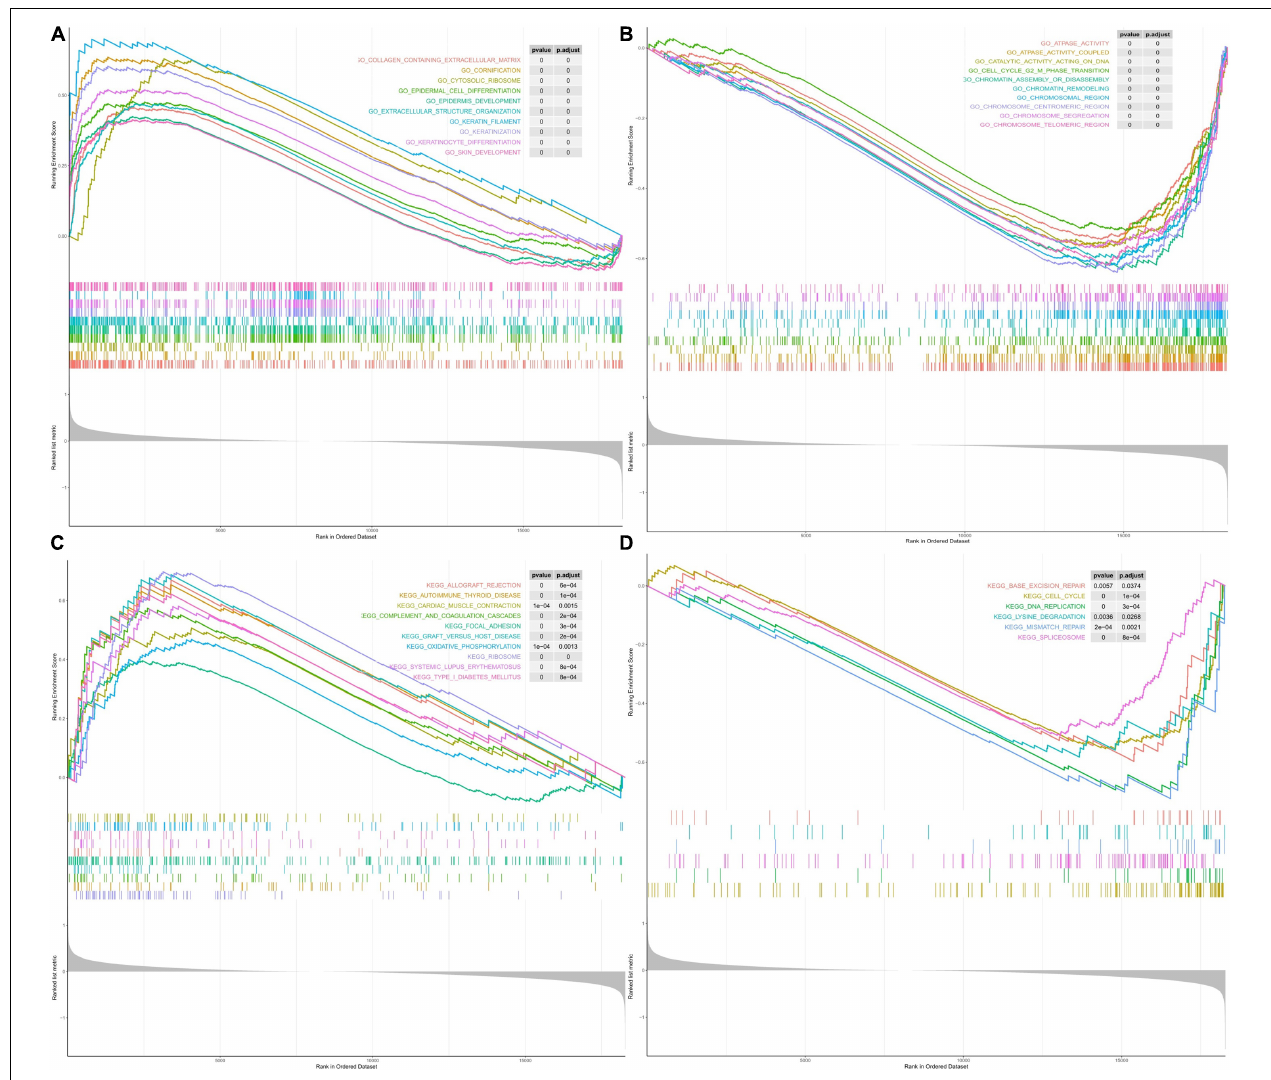
FIGURE 6 | Gene set enrichment analysis (GSEA). (A) The top 10 enriched GO pathways in the high-risk group. (B) The top 10 enriched GO pathways in the low-risk group. (C) The top 10 enriched KEGG pathways in the high-risk group. (D) The top 10 enriched KEGG pathways in the low-risk